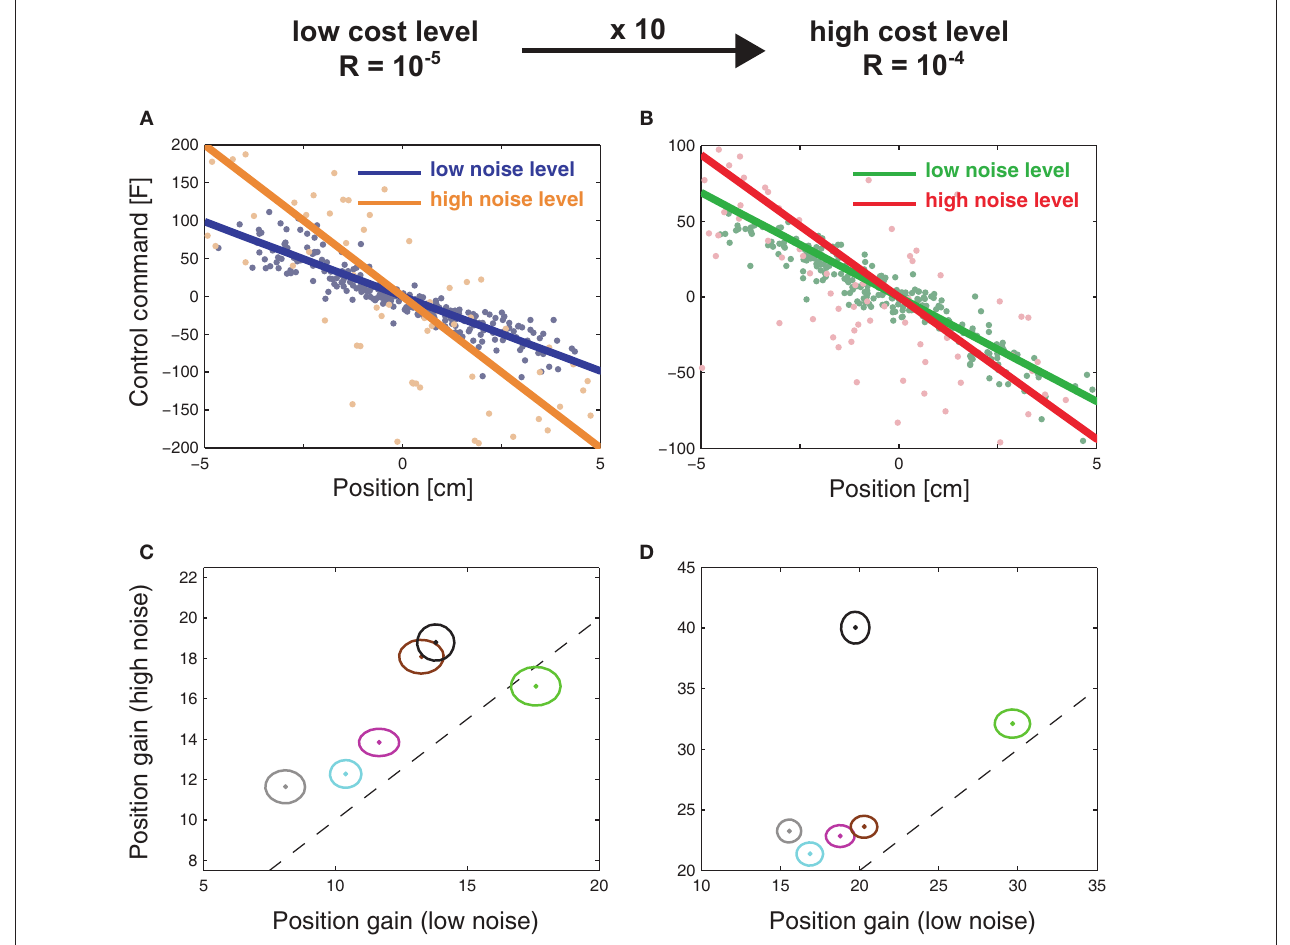
noise level). (C) Positional control gain for the high noise condition plotted against the control gains of the low noise condition for all six subjects under low control costs (ellipses show the standard deviation). The dashed line represents equality between the gains. (D) as (C) but for high control costs. In both cost conditions, the gains have changed significantly as most ellipses do not intersect with the dashed diagonal. This change in gains is consistent with a risk-sensitive optimal feedback control model, but not with a risk-neutral